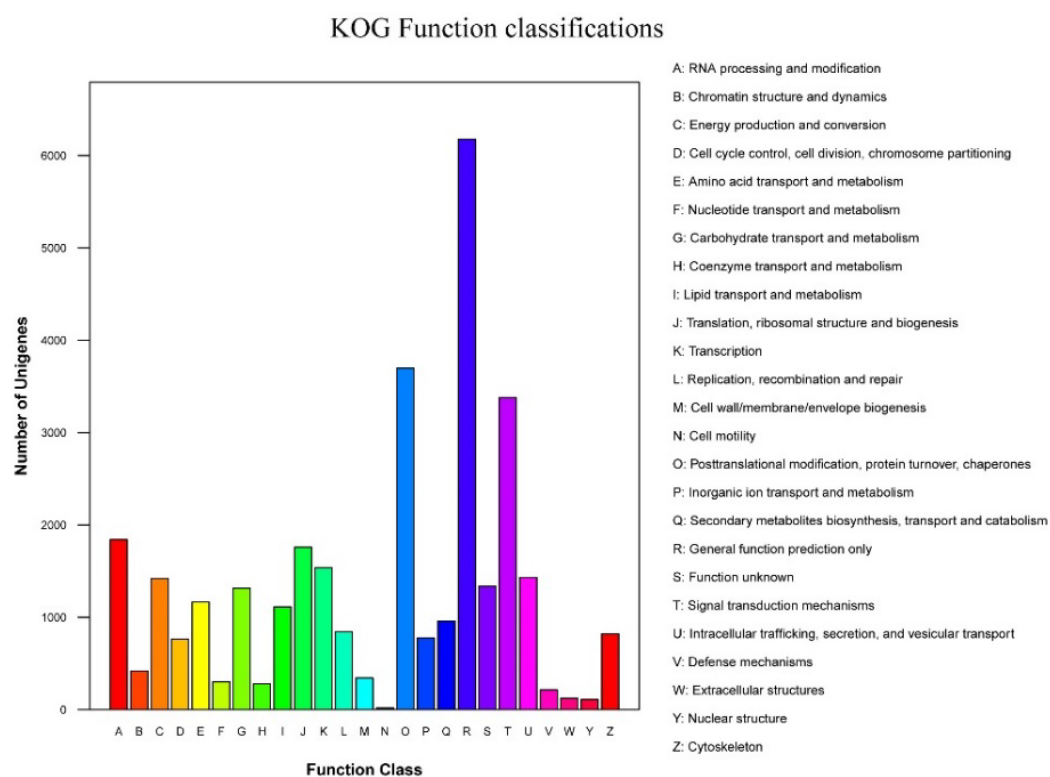
8 Figure 4. KOG functional classification of ‘Huaxiu’ plums ( P. salicina ) unigenes.